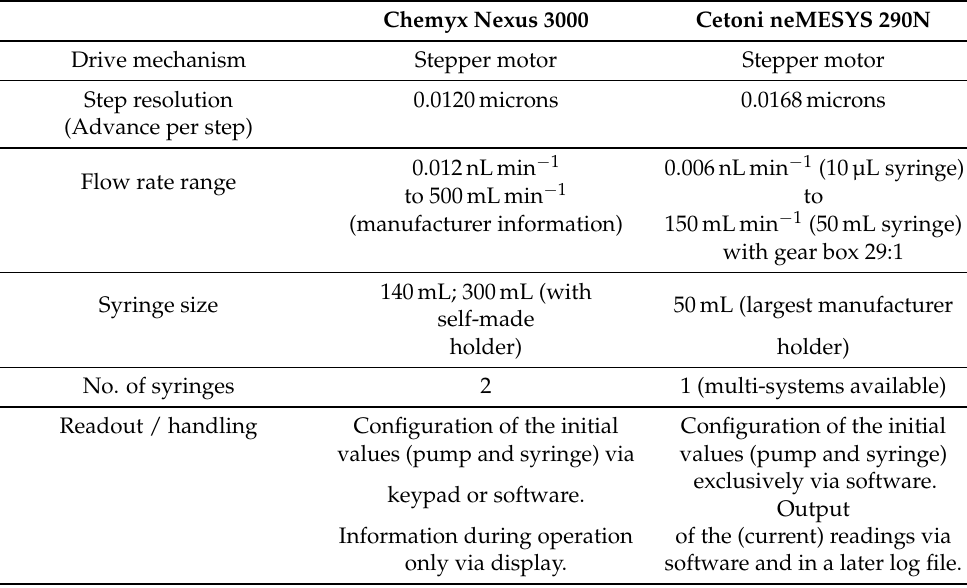
Figure 3. Schematic drawing of a typical measurement setup (Microflow test facility) for the calibra- tion of a flow meter as DUT. In this case, the drawing shows the CORI-FLOW M12 from Bronkhorst, which was used as a secondary standard. Table 1. Comparison of the two ultra-high precision syringe pumps used as flow